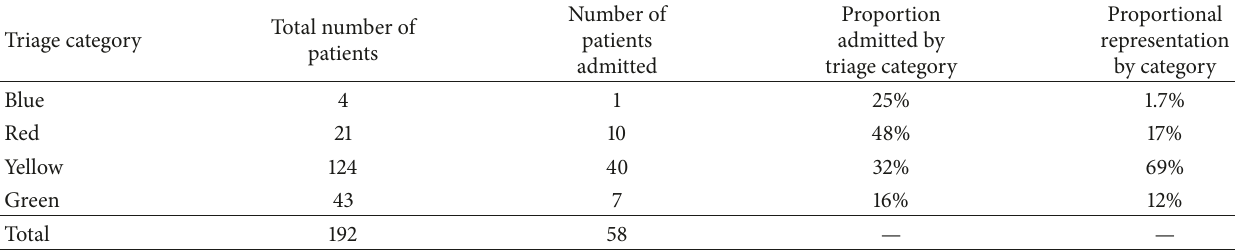
Table 3: Triage category of patients admitted and the time (hours) they spent waiting for a bed on the ward. Triage category < 1h > 1, < 2 h > 2h, < 3h Red Green 2